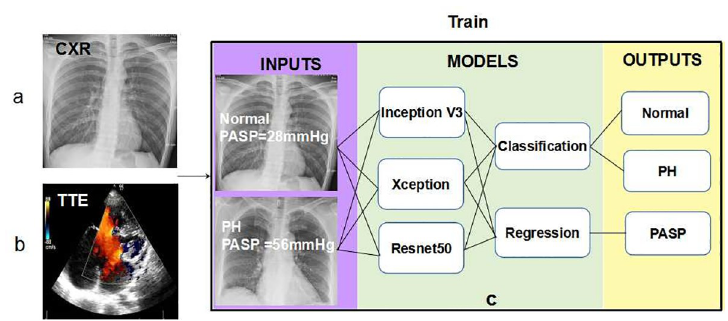
Fig 2. Schematic of labeling and training process. A Patient with or without PH receiving CXR screening (a). The same patient receiving TTE to identify PH by measuring PASP value with cutoff of 40 mmHg (b). Using retrospective CXR and corresponding PASP tags to train transfer learning models that can be deployed to diagnose PH and predict PASP according to the CXR of new patients (c). CXR, chest X-ray; TTE, transthoracic echocardiography; PH, pulmonary hypertension; PASP, pulmonary artery systolic